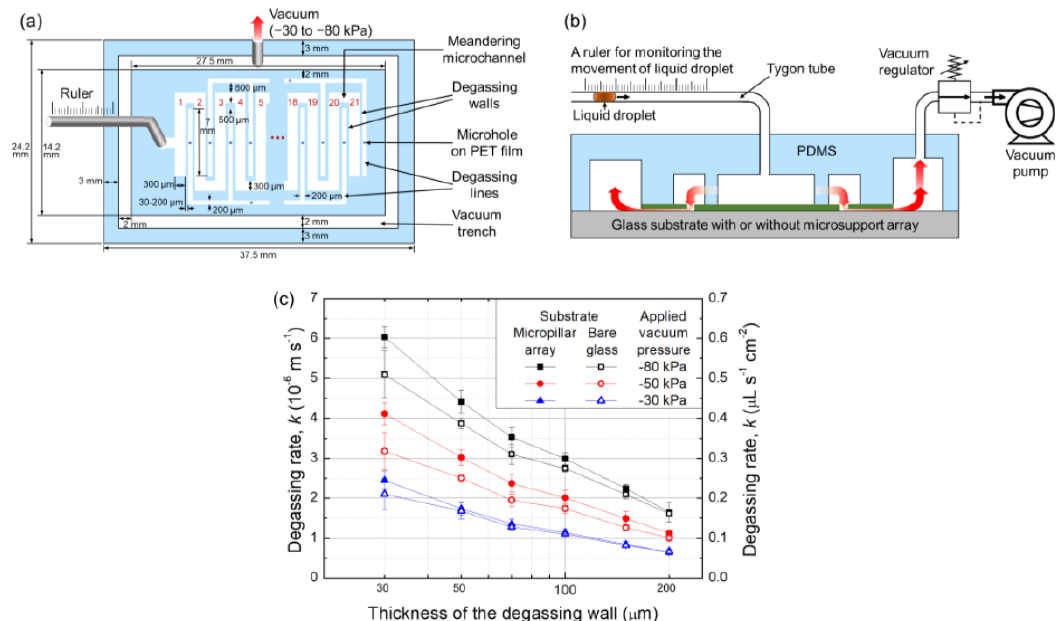
Figure 3. ( a ) Top view of the meandering microchannel for measuring the degassing rate using the lateral degassing method. A Tygon tube and a ruler were used to monitor the movement of a liquid droplet. ( b ) Experimental setup to measure the degassing rates according to the thickness of the degassing wall. ( c ) Degassing rates measured using a 4.2 µ m high micropillar array substrate and a bare glass substrate.